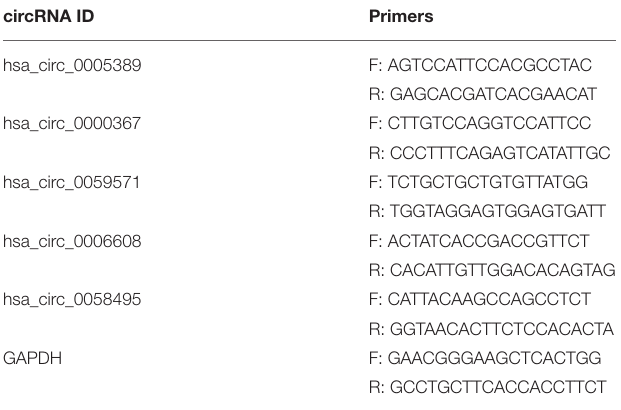
TABLE 1 | Primers for RT-qPCR. circRNA ID